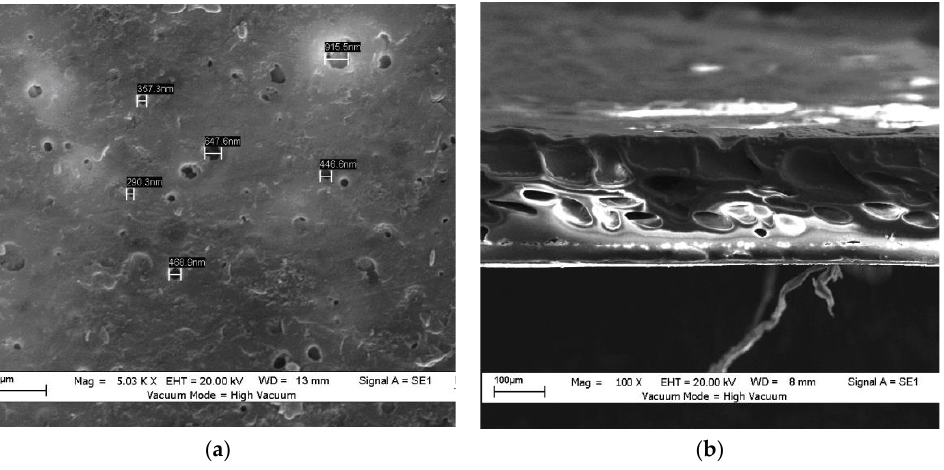
Figure 2. SEM images: ( a ) top surface of the hydrophobic membrane, and ( b ) cross-section of the hydrophobic membrane.